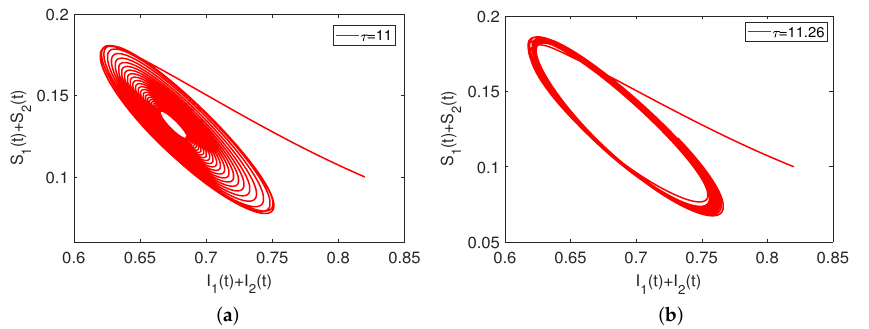
Figure 14. ( a ) The phase diagram of S 1 ( t ) + S 2 ( t ) with τ = 11. ( b ) The phase diagram of S 1 ( t ) + S 2 ( t ) with τ = 11.26.